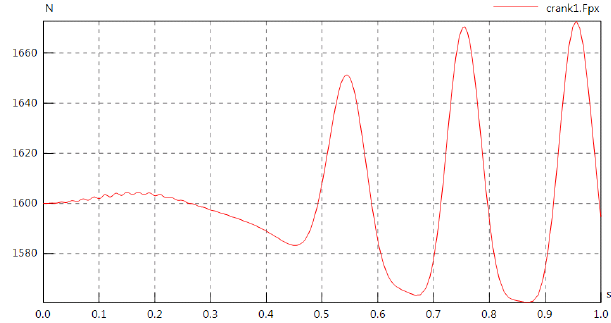
Figure 3. A graph of the longitudinal force acting on the slider for a typical machine.